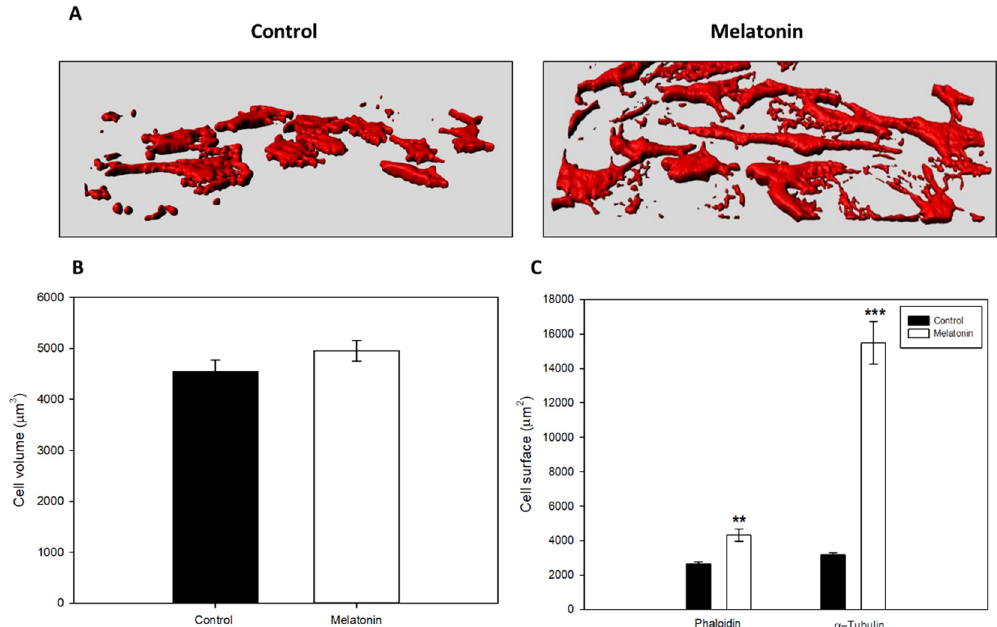
Figure 2. Morphological changes of B16-F10 cells after 24 h of treatment with melatonin. ( A ) 3D reconstruction of cell culture based on F-Actin distribution. Red areas represent the surface occupied by F-Actin ( B ) Average cell volume based on F-Actin distribution. ( C ) Average cell surface based on F-Actin distribution and α -tubulin. Data were shown as average +/ − SEM. Significance vs. CON. ** P < 0.01, *** P < 0.001